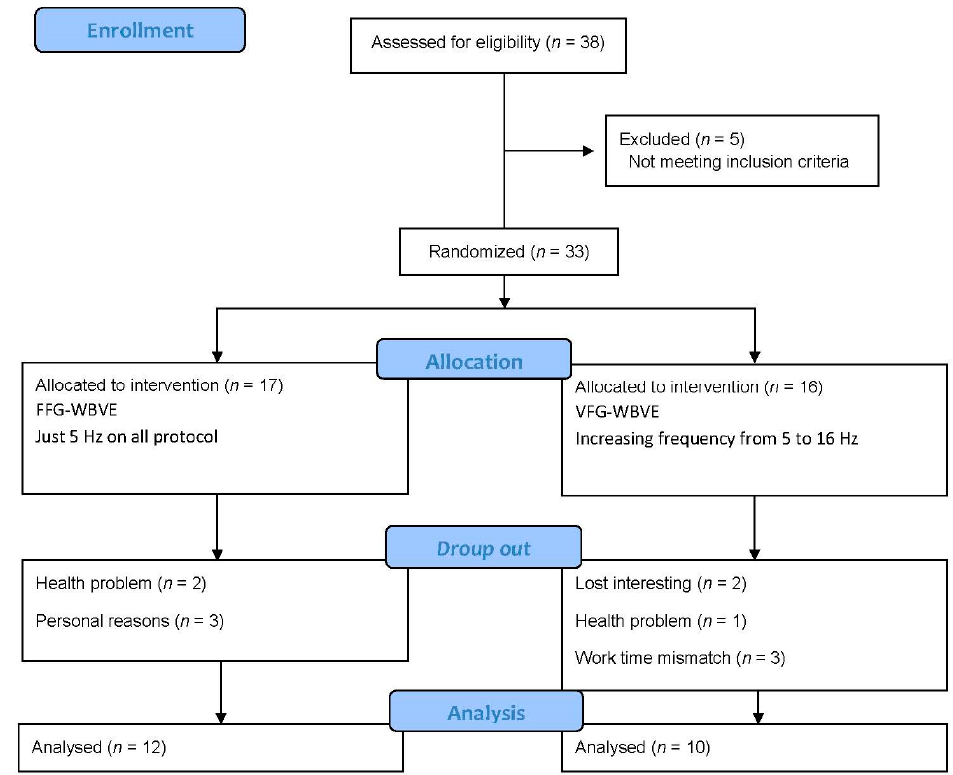
Figure 3. Flow of patients through the intervention.